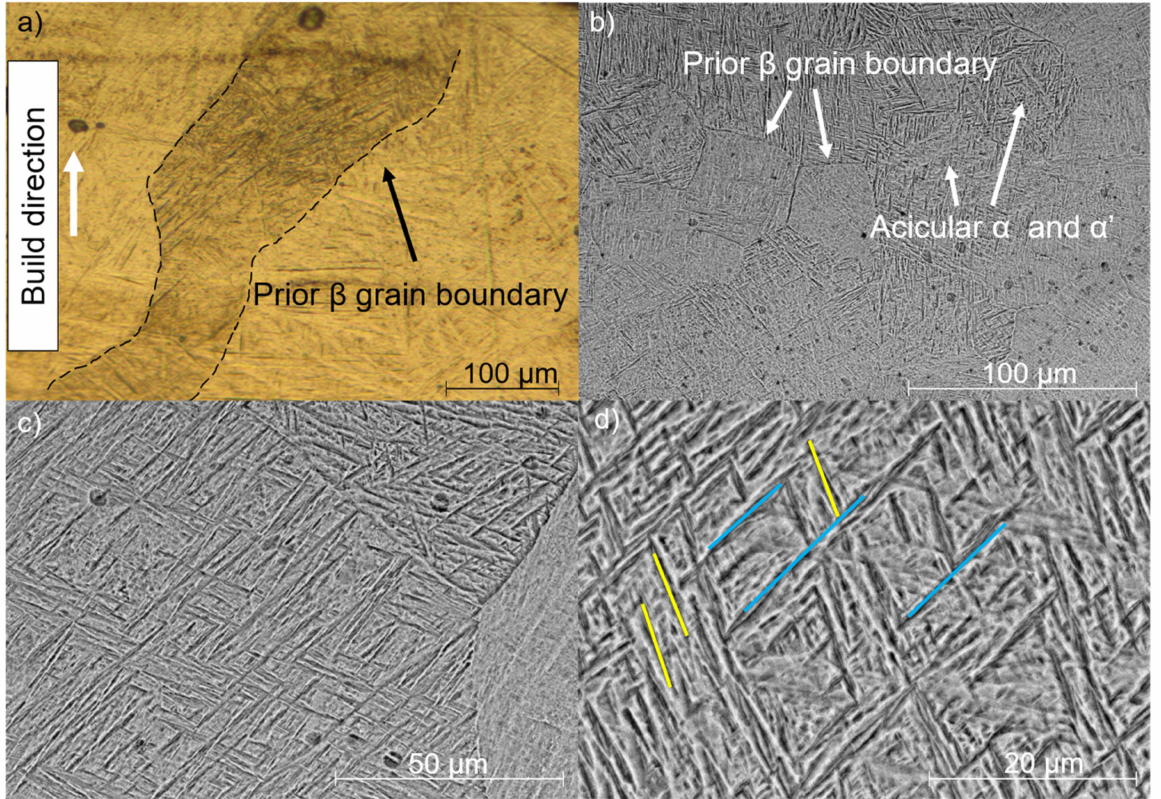
Figure 8. Microstructure of the Ti-33 × 1 specimen: ( a ) OM; ( b ) SEM; ( c ) detail of b; and ( d ) detail of the orientation of the needles formed, which are parallel in different directions (yellow for one direction and blue for